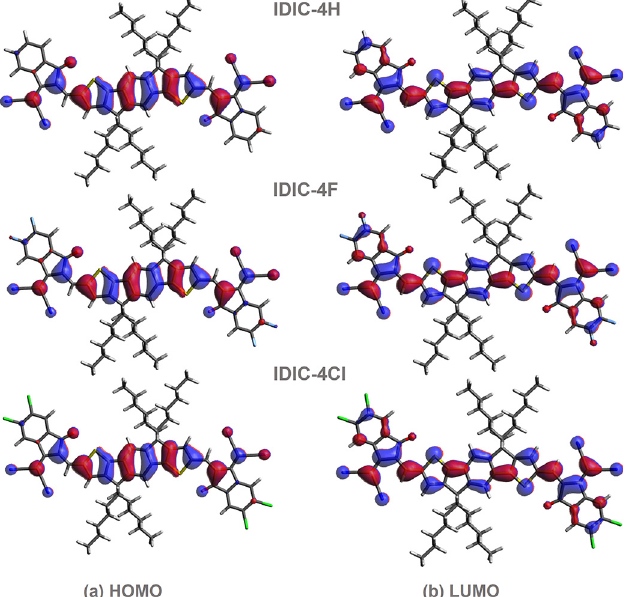
Fig. 2. Orbital distributions for the three compounds IDIC-4H, IDIC-4F, IDIC-4Cl. (a) HOMO, (b)